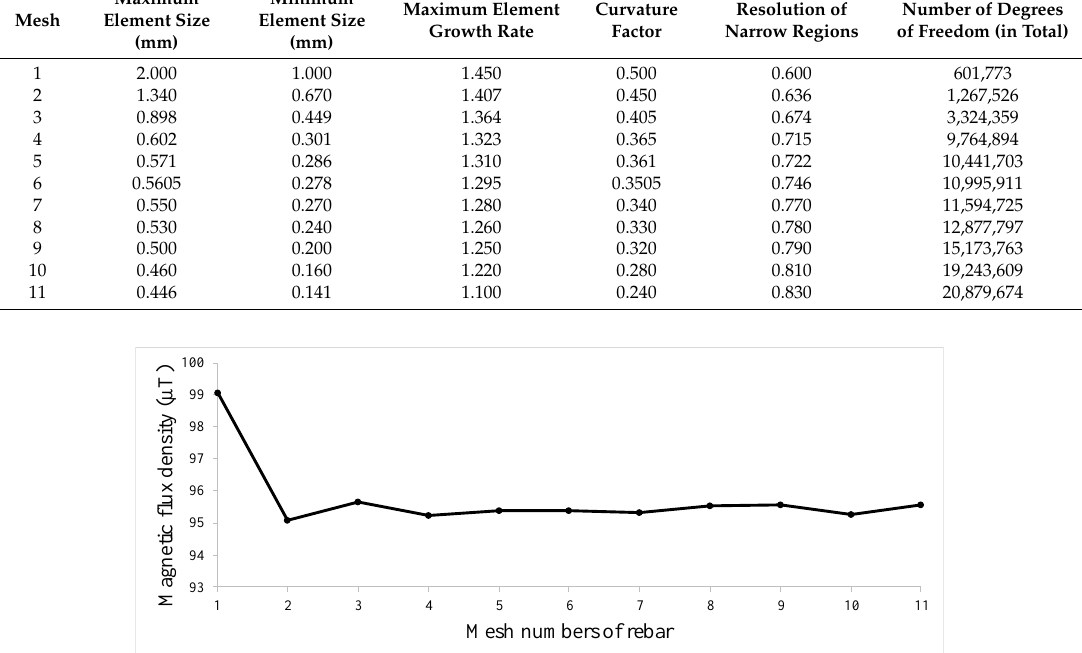
Table 4. Different mesh specifications of rebar, with the fixed mesh specifications of box mesh as #1.